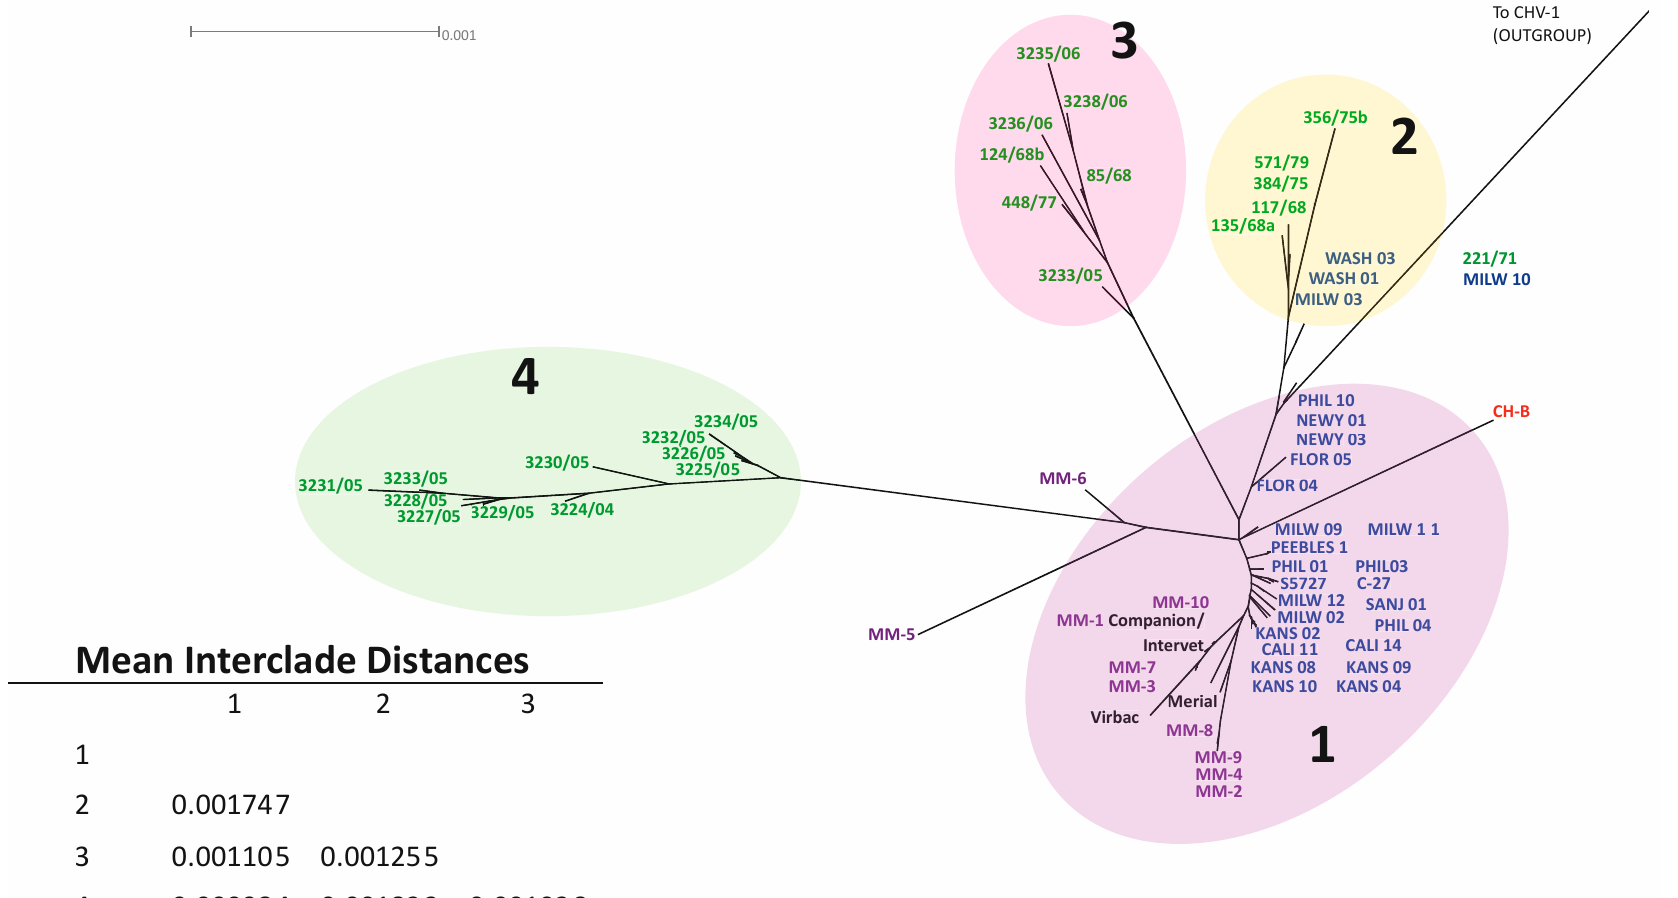
Figure 2. Phylogenetic tree including all currently available FHV-1 sequences with a CHV-1 outgroup. Domestic cat FHV-1 isolates from the USA are shown in blue, one isolate from China is shown in red, isolates from Australia in green, isolates from modified live vaccines (MLV) in black, and cheetah FHV-1 isolates are shown in purple. Four clades are shown: Clade 1 includes only USA isolates (with vaccine strains and cheetah strains), Clade 2 includes both Australian and USA isolates, and Clade 3 and Clade 4 contain only Australian isolates. Mean interclade distances were calculated using MEGAX. MM-2, MM-3, MM-7, and MM-9 were isolated from cheetahs known to be vaccinated with the Merial brand MLV. All 4 of these isolates show a very high degree of similarity to the MLV.